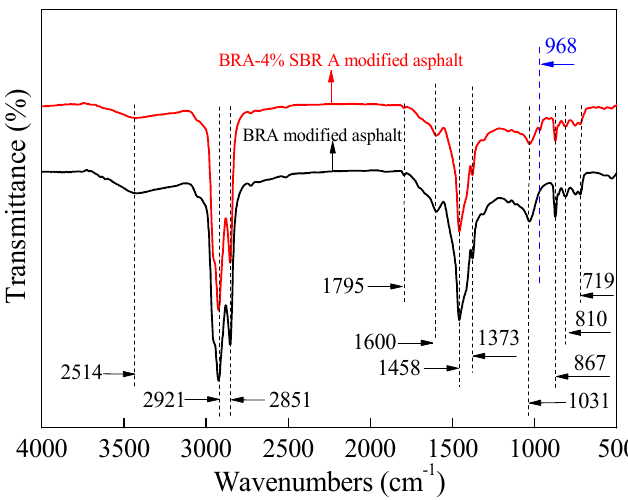
Figure 8. Fourier transform infrared spectroscopy (FTIR) of BRA modified asphalt before and after modifying by 4%SBR A. Table 5. Functional group of BRA modified asphalt.